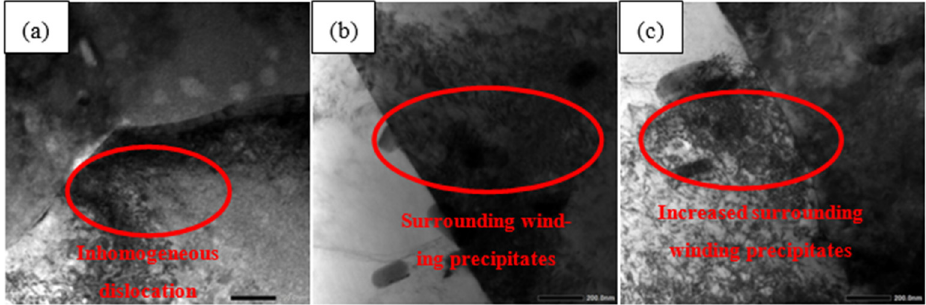
Figure 13. Dislocation morphology of the 2024 FSWed joints with different deformations ( a ) 4%, ( b ) 7%, ( c ) 10%. ( b ) 7%, ( c )